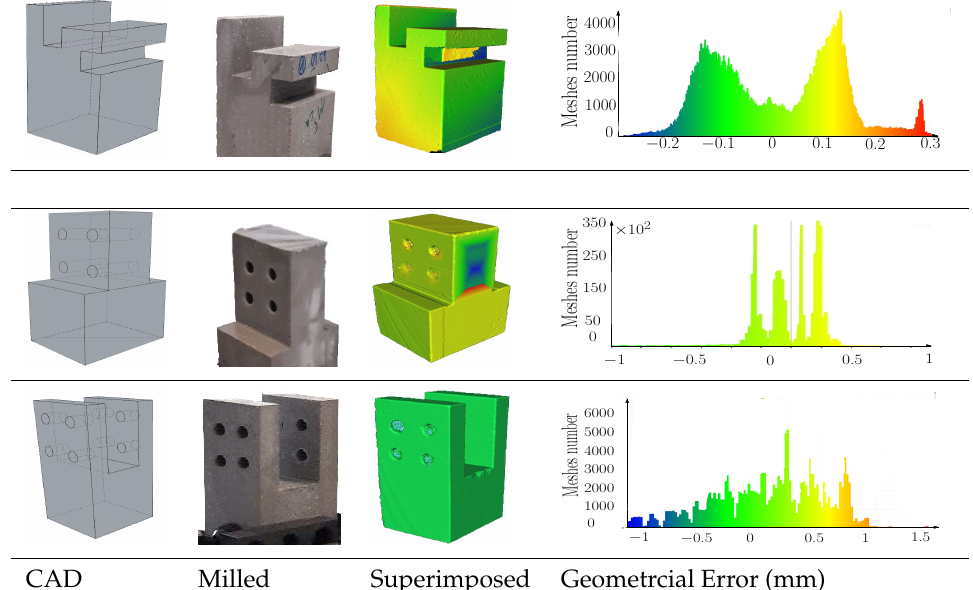
Figure 25. Evaluation of the subtracted 3D geometrical error of the milled geometries of F7 and F8 in comparison with initial CAD model (CloudCompare